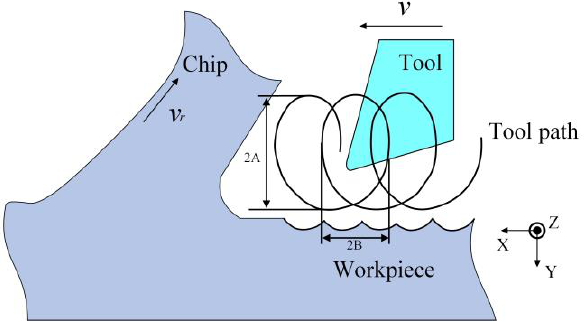
Figure 1. Schematic diagram of UEVC.